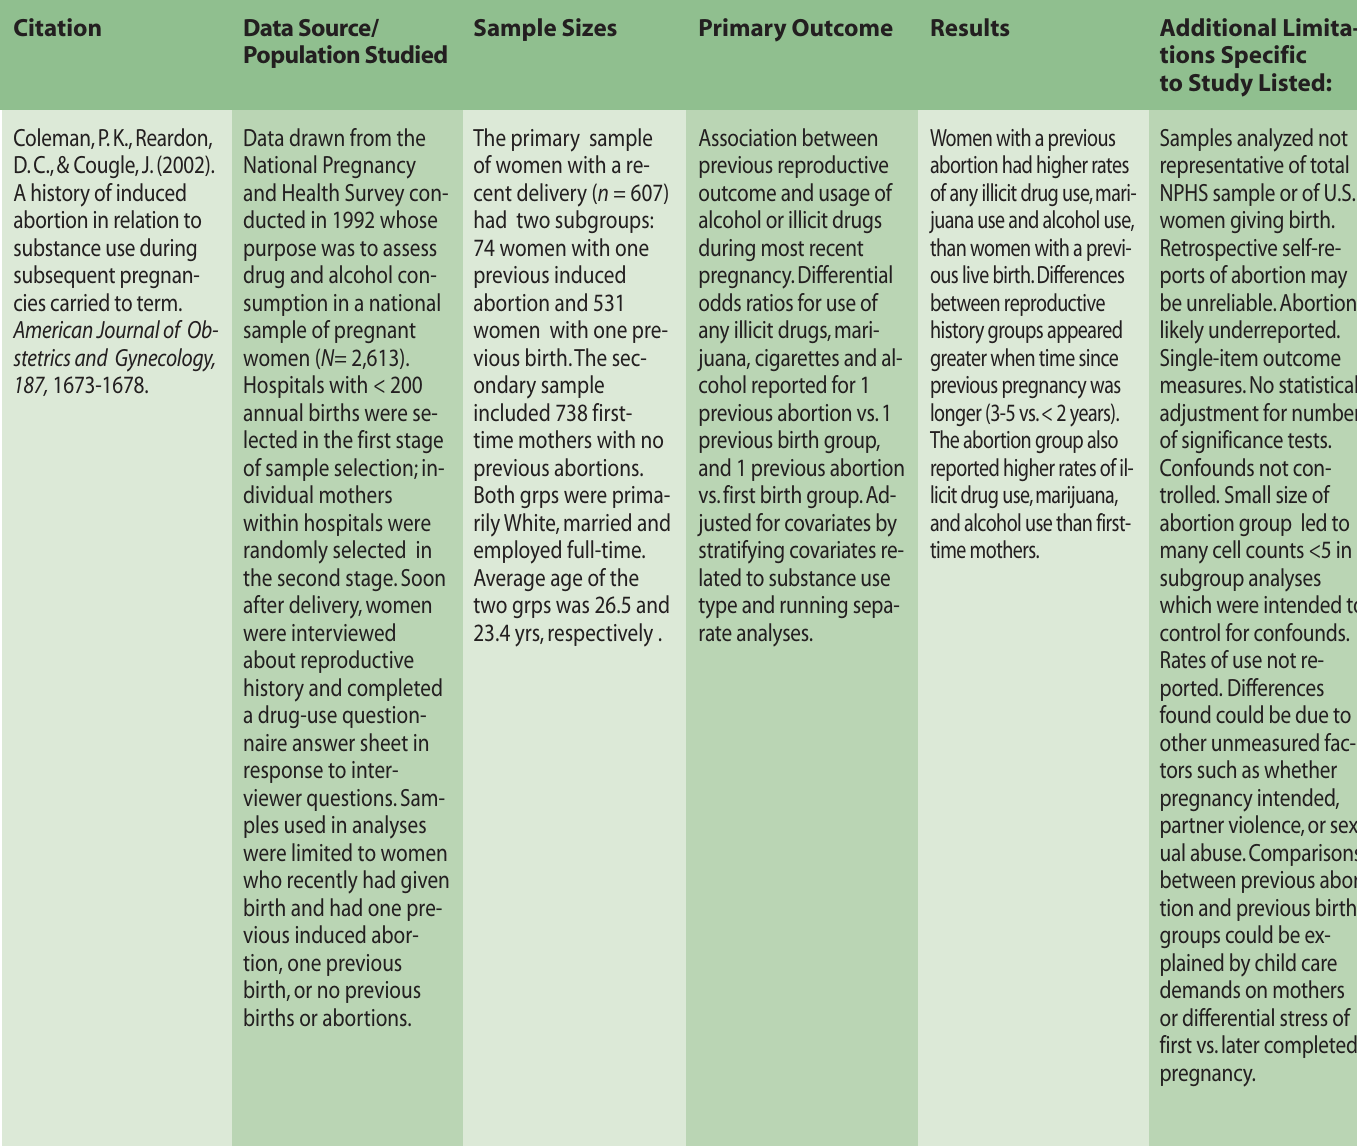
Table 2: Secondary Analyses of Survey Data–Abortion vs.Comparison